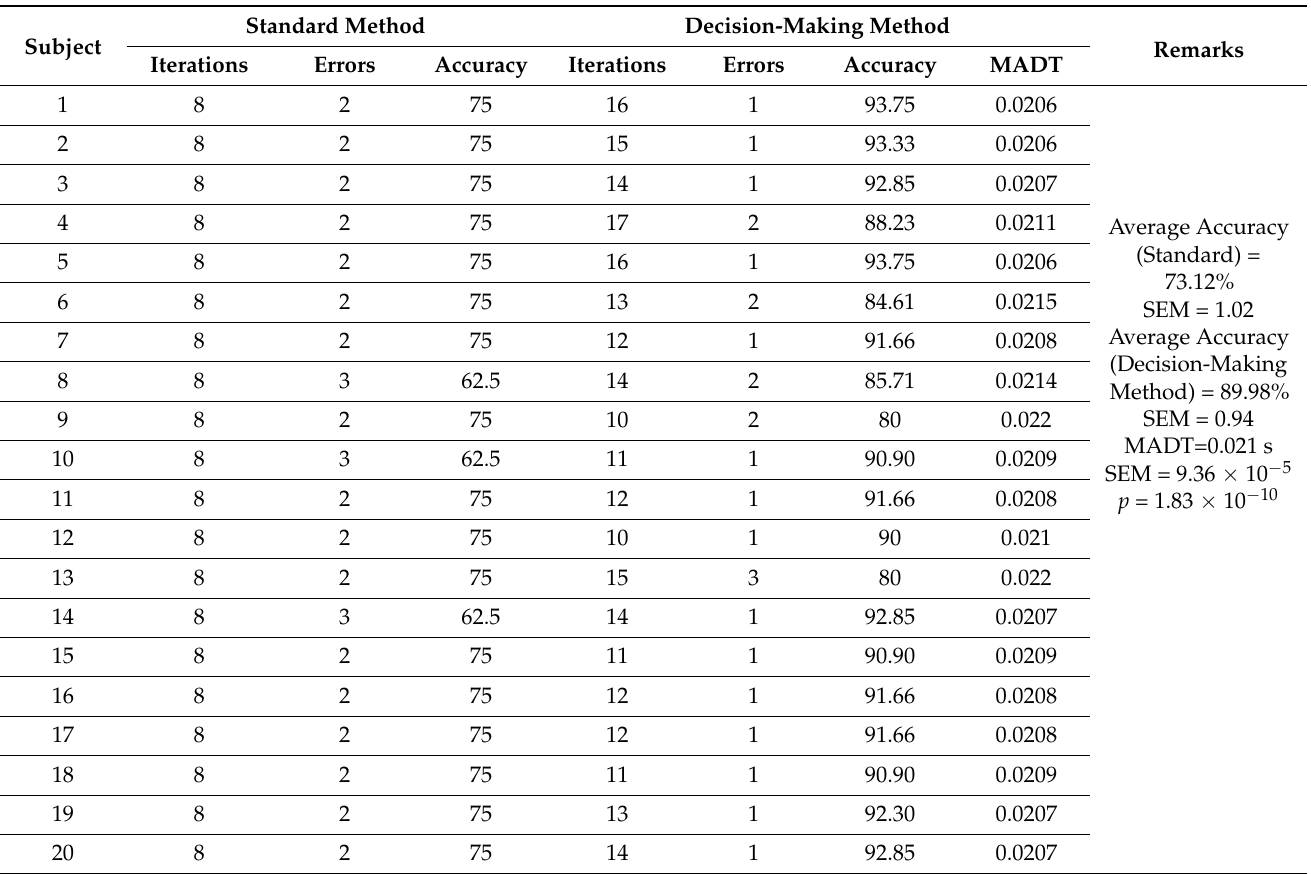
Table 5. Accuracy of two methods: mean automated decision-time and the